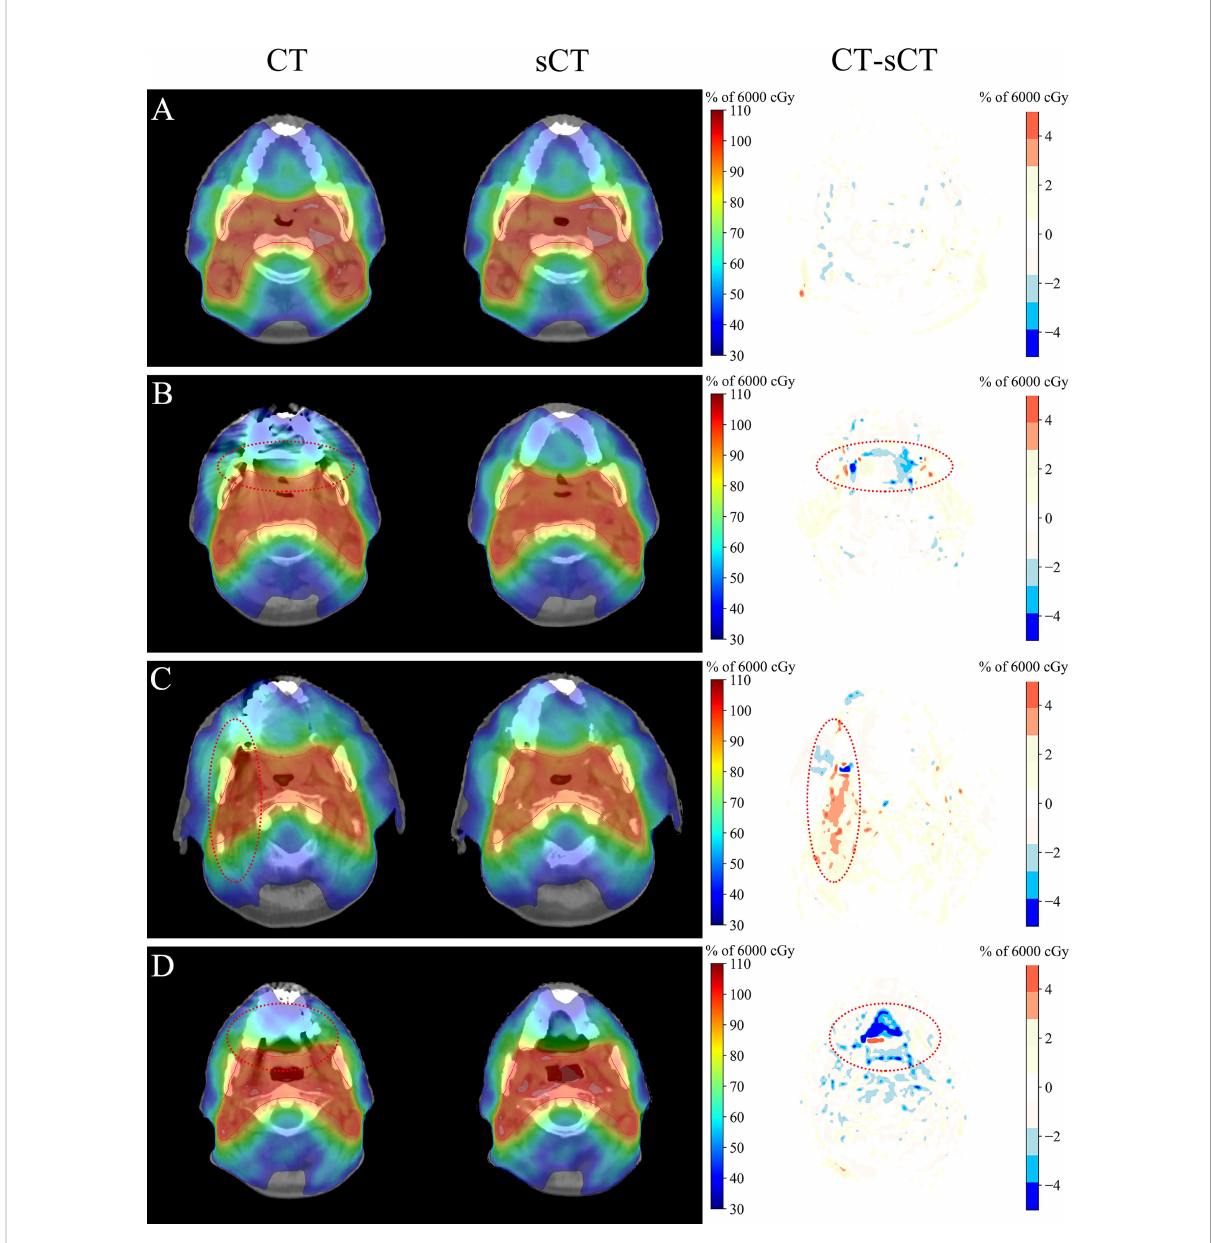
FIGURE 5 Dosimetric comparison of CT and sCT images. (A) Metal-free images. (B – D) Metal-containing images. The display window for the CT and sCT images was [-360, 440] HU. The dose distribution of sCT_MF images was consistent with that of CT_MF images, and there were obvious dose differences between CT_M and sCT_M images in the area with serious metal